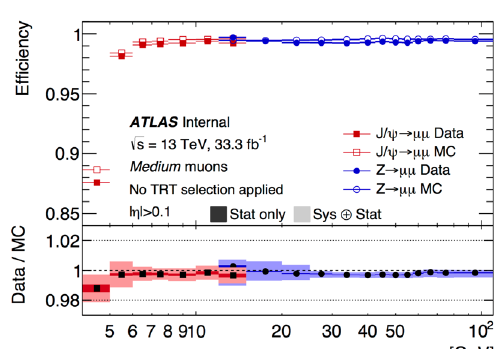
Figure 1. Muon reconstruction e ffi ciencies for the Loose / Medium / Tight identification algorithms µµ events as a function of the muon measured in Z → pseudorapidity for muons with p T > 10 GeV. The prediction by the detector simulation is depicted as open circles, while filled dots indicate the observation in collision data with statistical errors. The bottom panel shows the ratio between expected and observed e ffi ciencies, the e ffi ciency scale factor. The errors in the bottom panel show the quadratic sum of statistical and systematic uncertainty. Figure from [5].